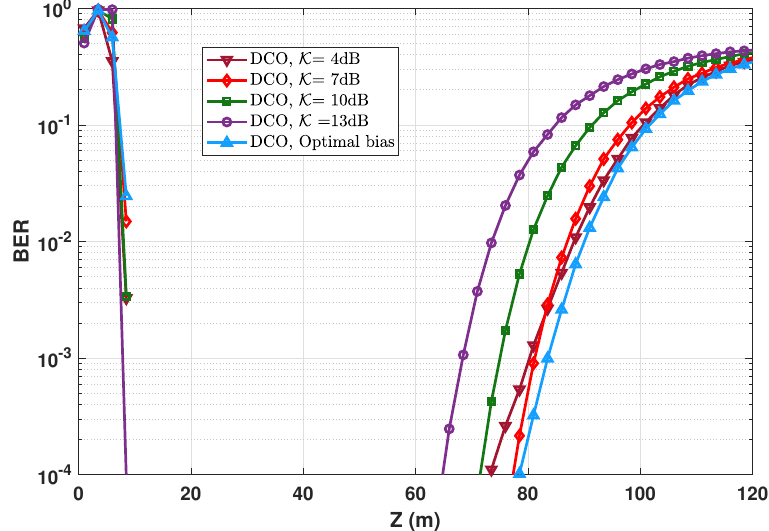
Figure 13. BER performance of DCO-OFDM using optimized and non-optimized DC bias. One LED at the Tx with P Tx,e = 50mW; N = 1024; N CP = 9; R b = 20Mbps. The corresponding clipping factors are = 2.932), and α = 0.145, 0.0922, 0.062, and 0.0432 α = 0.12 for the optimum bias (corresponding to B DC = 2.9279, 2.9344, 2.9357, and 2.9377V), for K dB = 4, 7, 10, and 13dB (corresponding to B DC